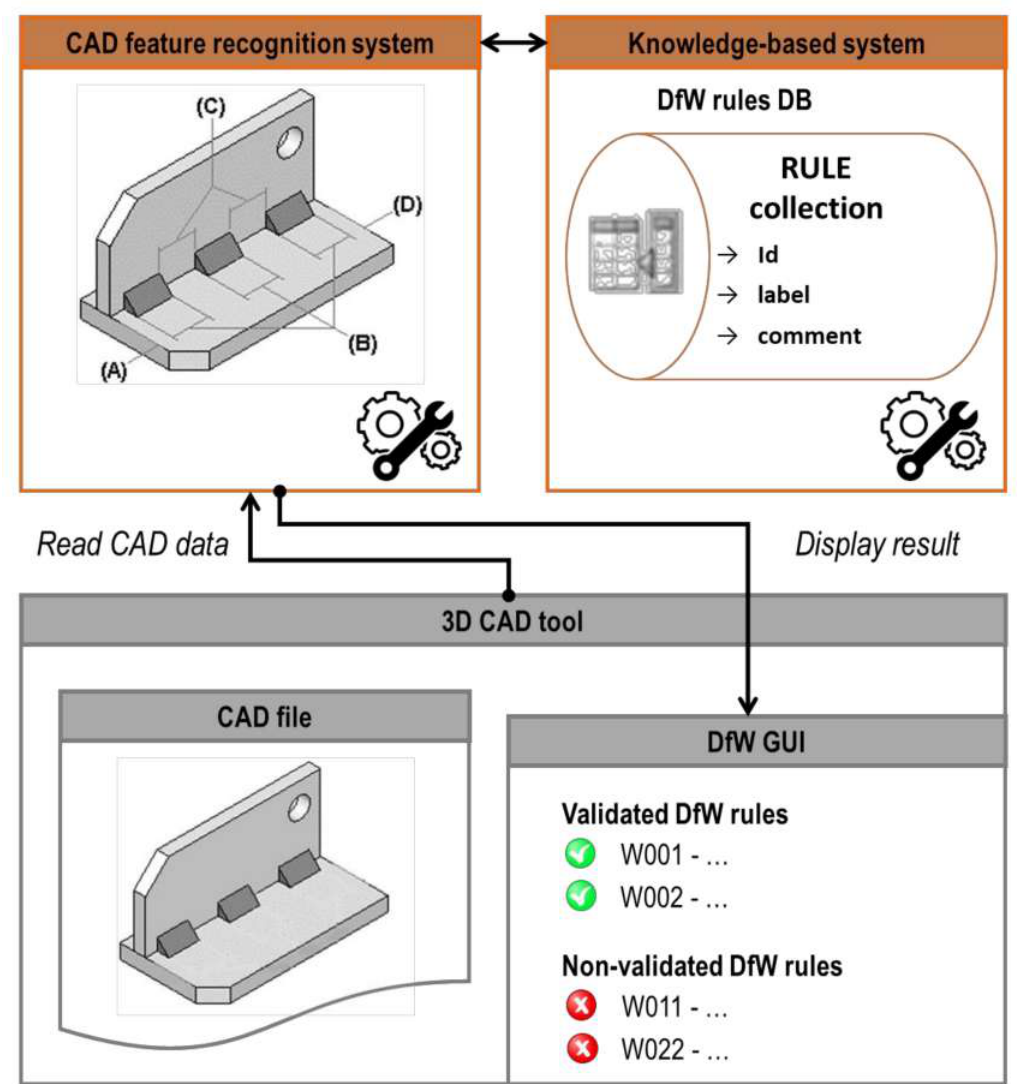
Figure 1. The system architecture of the methodology. ( A ) CAD feature recognition system, ( B ) Knowledge based system, and ( C ) DfW GUI embedded in the 3D CAD